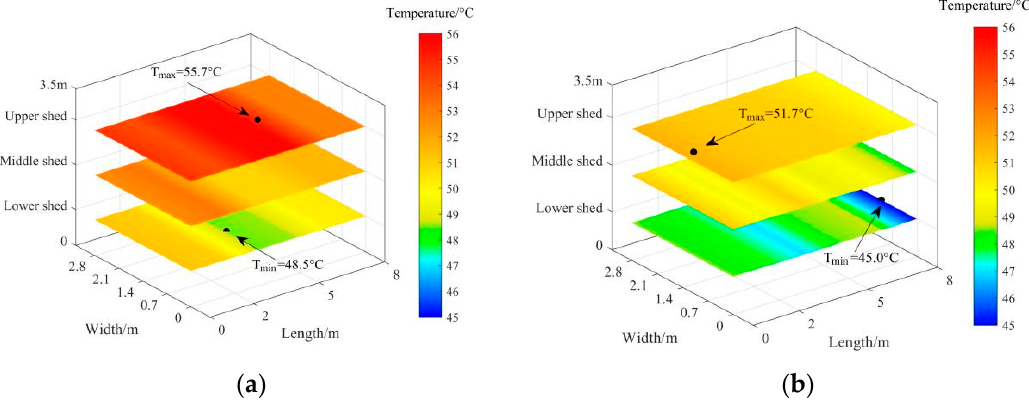
Figure 6. The temperature distribution of ( a ) TCCB and ( b ) HPCB with a curing temperature of 42 °C.